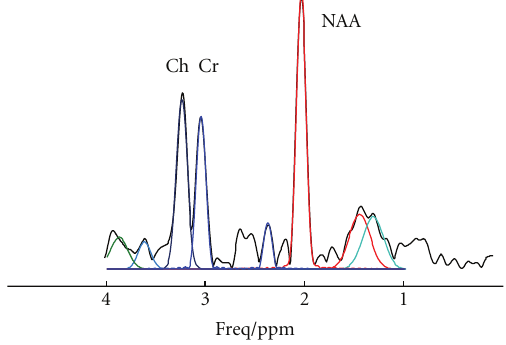
Figure 4: An example of spectral fitting of the in vivo data in the time domain for 256 data points, displayed in the frequency domain and absolute mode. Shown in colors are the individual fitted spectral lines overlaid on the measured spectrum in black. The excellent fitting supports the merit of spectral fitting in the time